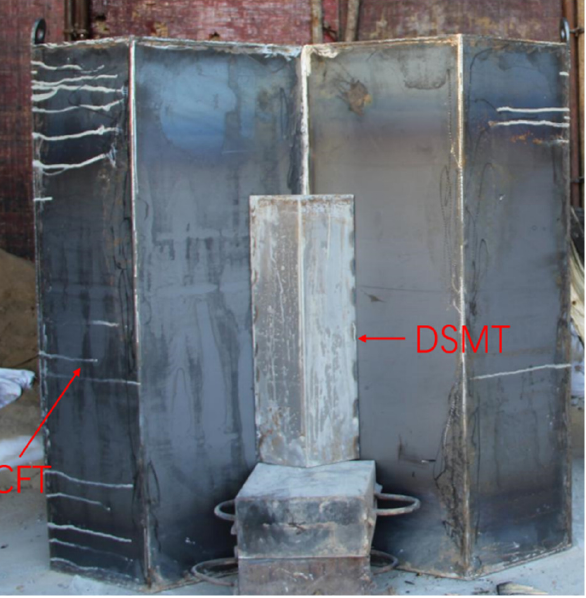
Figure 5. Photograph of the composite target plate with diamond-shaped moving target. The diameter of the projectile is 76 mm, and the length-to-diameter ratio is 6. The ratio of the radius of curvature of the head to its diameter is 3, and the weight of the pro- jectile is about 14.1 kg, while the weight of the diamond-shaped moving target is about 28.2 kg, thus the mass ratio of them is 1:2. The projectile material is ultra-high-strength alloy steel 30CrMnSiNi2A, the yield strength is 1766 MPa, and the Rockwell hardness of the material after heat treatment is not less than 45. Using sub-aperture launch technology, the photo of the 76 mm test projectile body and the split-lobe stock is shown in Figure 7.